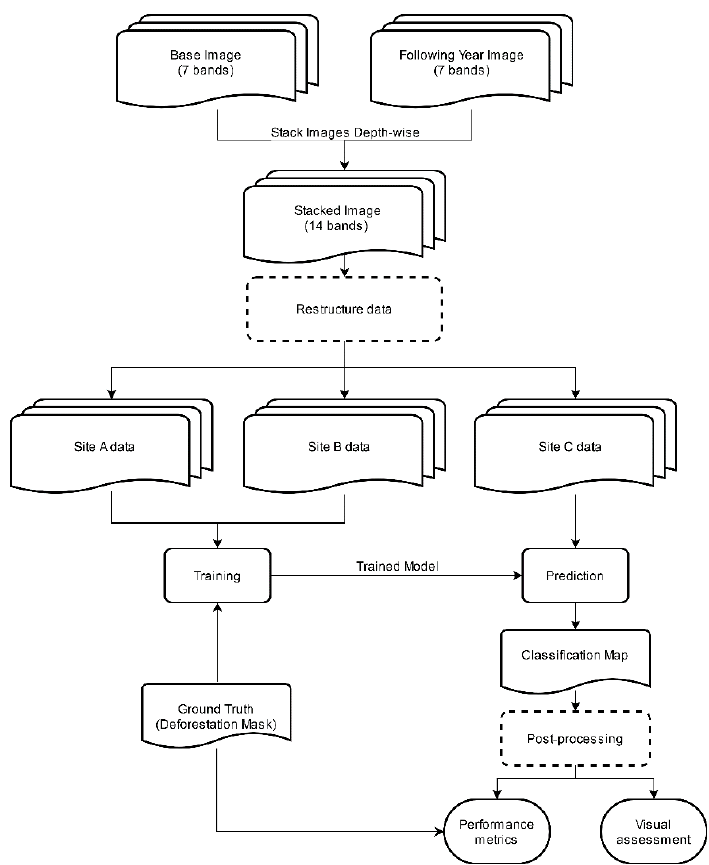
Figure 5. Flowchart of the modeling approach taken in this study.